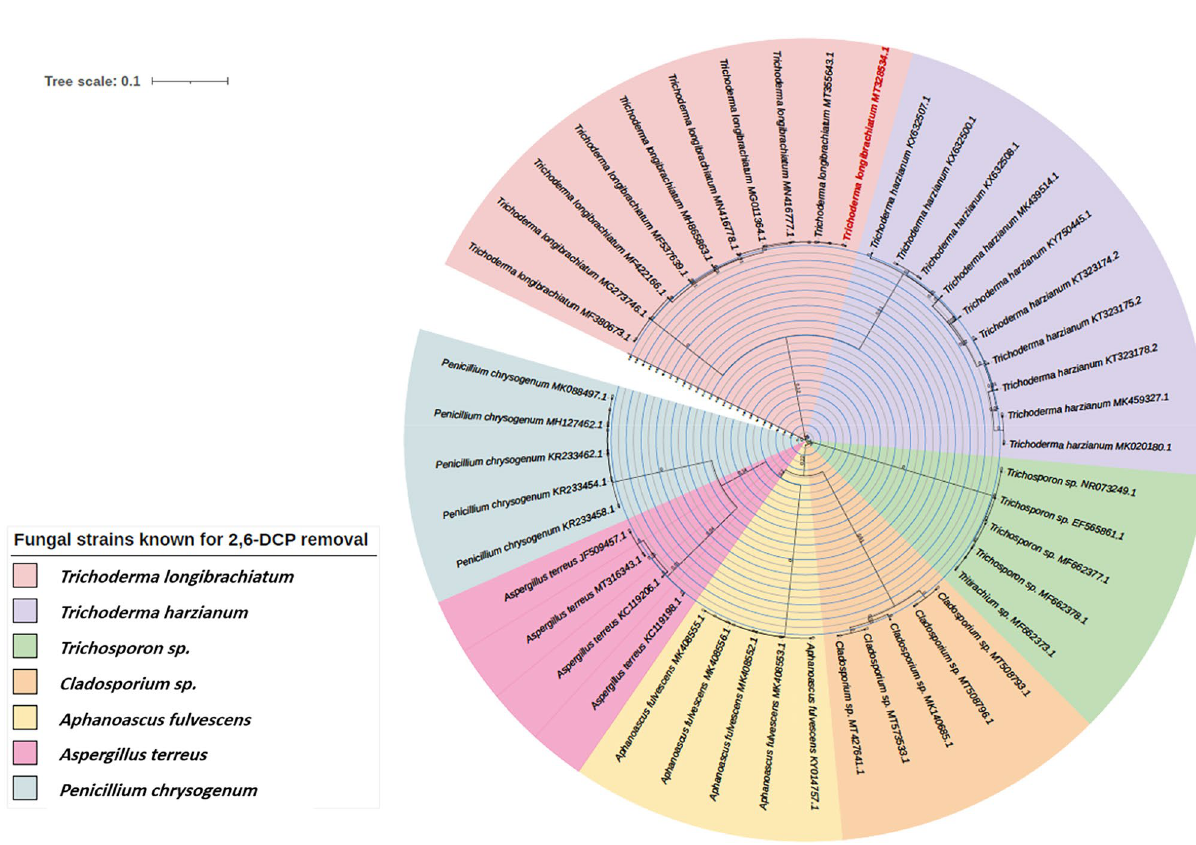
Figure 2. Neighbour-joining tree from ITS sequences showing the relationship between the known 2,6-DCP tolerant fungus, sequences of the isolates retrieved from the GenBank